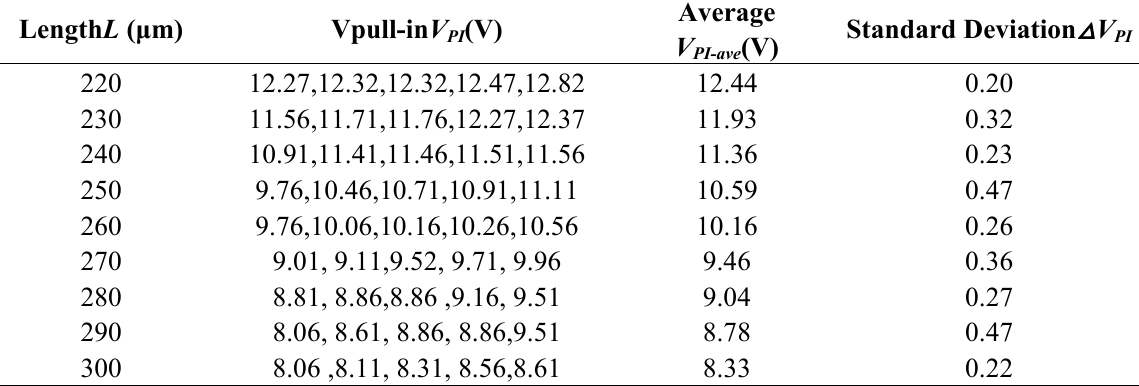
Table 7. The average and standard deviation of pull-in voltage value of each test